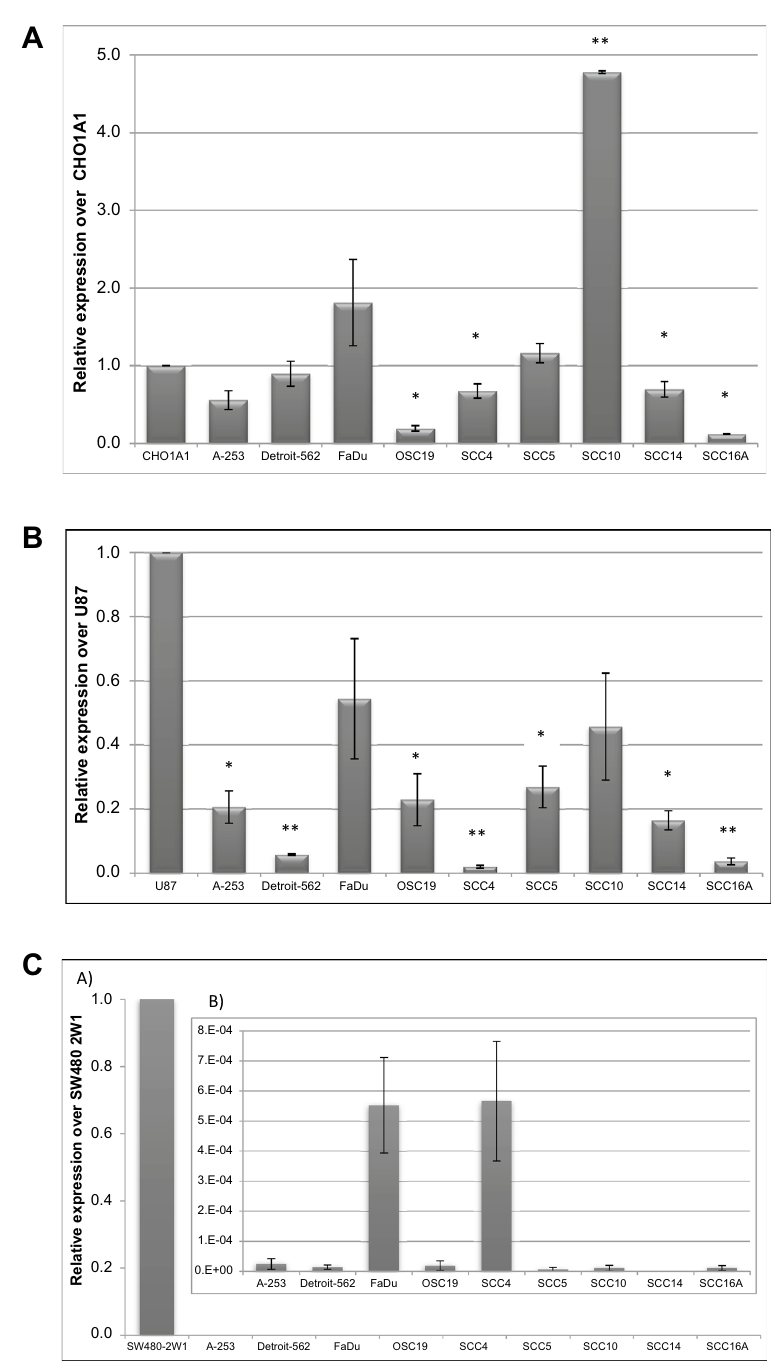
Figure 2. ( A ) Relative mRNA expression of CYP1A1 in a panel of HNC cell lines. Fold change relative to CHO1A1. Values are the mean of 3 independent experiments and error bars represent standard deviation (SD). [*P ≤ 0.05; **P ≤ 0.01 relatively to CHO1A1]. ( B ) Relative mRNA expression of CYP1B1 in a panel of HNC cell lines. Fold change relative to U87. Values are the mean of 3 independent experiments and error bars represent standard deviation (SD). [Relatively to U87: *P ≤ 0.05; **P ≤ 0.01]. ( C ) Relative mRNA expression of CYP2W1 in a panel of HNC cell lines. Fold change relative to SW480 2W1. Relative expression over CYP2W1 with scale bar between 0 and 1 ( A ) and scale bar between 0 to 8 × 10 –8 ( B ). Values are the mean of 3 independent experiments and error bars represent standard deviation